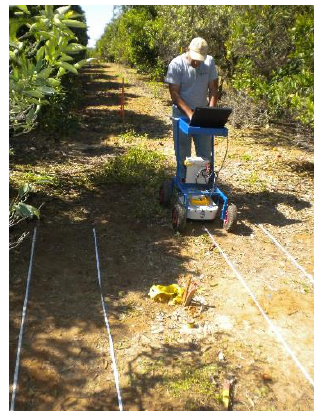
Figure 5. GPR cross-section field measurement in Bnei-Dror